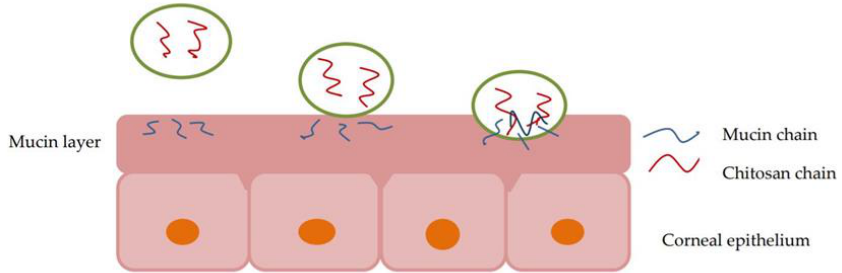
Figure 3. Interactions between chitosan chains and the mucin layer.